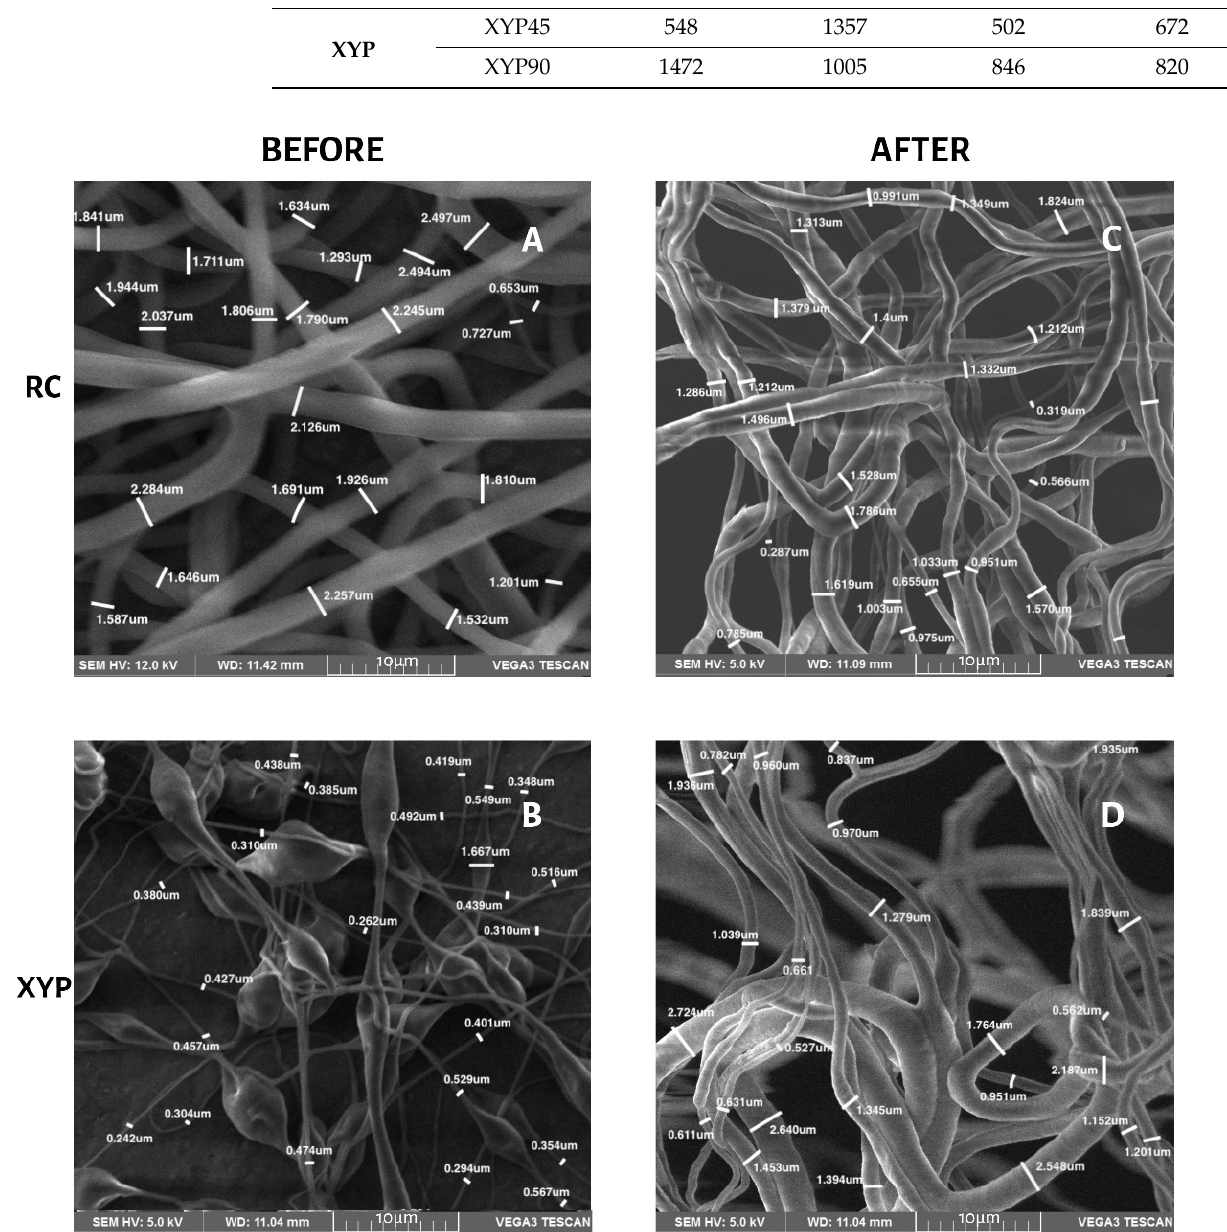
Figure 4. Fiber diameter in SEM micrographs, 45 min of deposition. ( A ) RC45 before mechanical